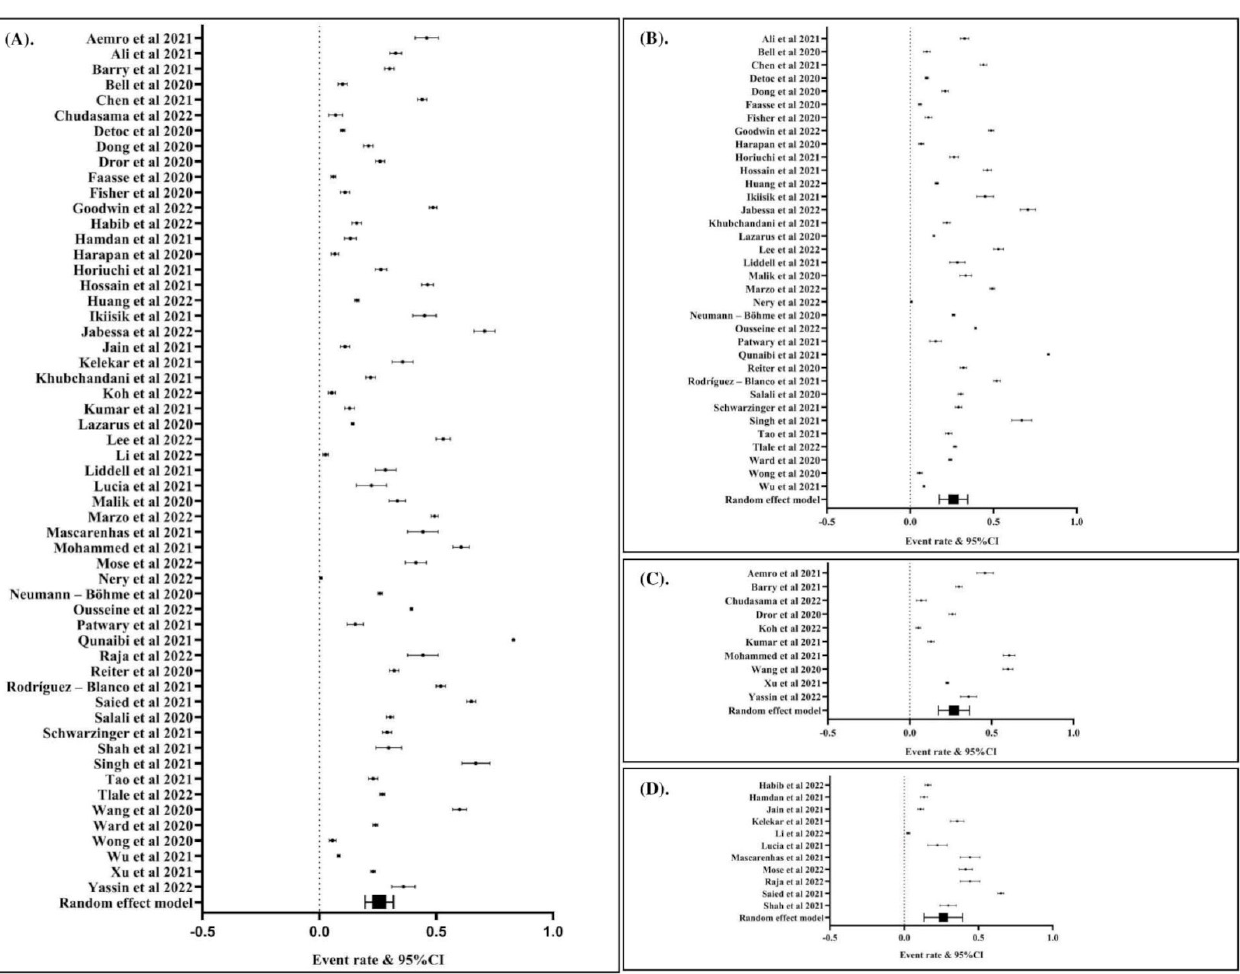
Figure 2. The global prevalence of hesitancy to COVID-19 vaccination (event rate: 0.25; 95% CI: 0.20, 0.32; p Egger: 1.2580; p heterogeneity: <0.0001; p : <0.0001) ( A ). The prevalence of hesitancy to COVID-19 vaccination among general population (event rate: 0.25; 95% CI: 0.18, 0.34; p Egger: 1.3090; p heterogeneity: <0.0001; p : <0.0001) ( B ). The prevalence of hesitancy to COVID-19 vaccination among healthcare workers (event rate: 0.26; 95% CI: 0.18, 0.37; p Egger: 0.7670; p heterogeneity: <0.0001; p : <0.0001) ( C ). The prevalence of hesitancy to COVID-19 vaccination among students (event rate: 0.25; 95% CI: 0.14, 0.40; p Egger: 1.2090; p heterogeneity: <0.0001; p : 0.0030) ( D ). The studies included are provided in the reference list [19,25–79].